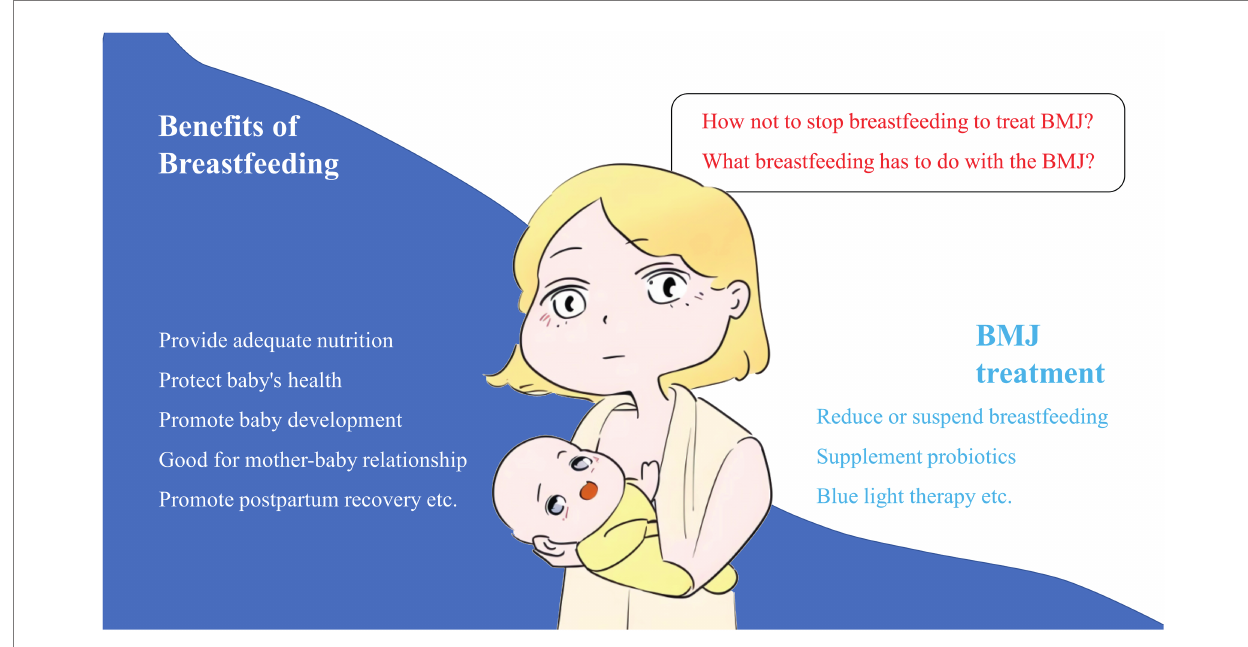
FIGURE 1 The benefits of breastfeeding and the main modalities for treating BMJ, as well as issues to